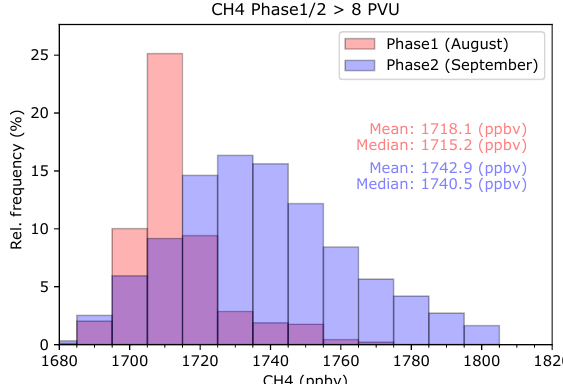
Figure 4. Frequency distribution of CH 4 for the lower stratosphere (PV > 8PVU) for phase 1 (red) and phase 2 (blue). The mean and median values of each distribution are given in red and blue, respec-